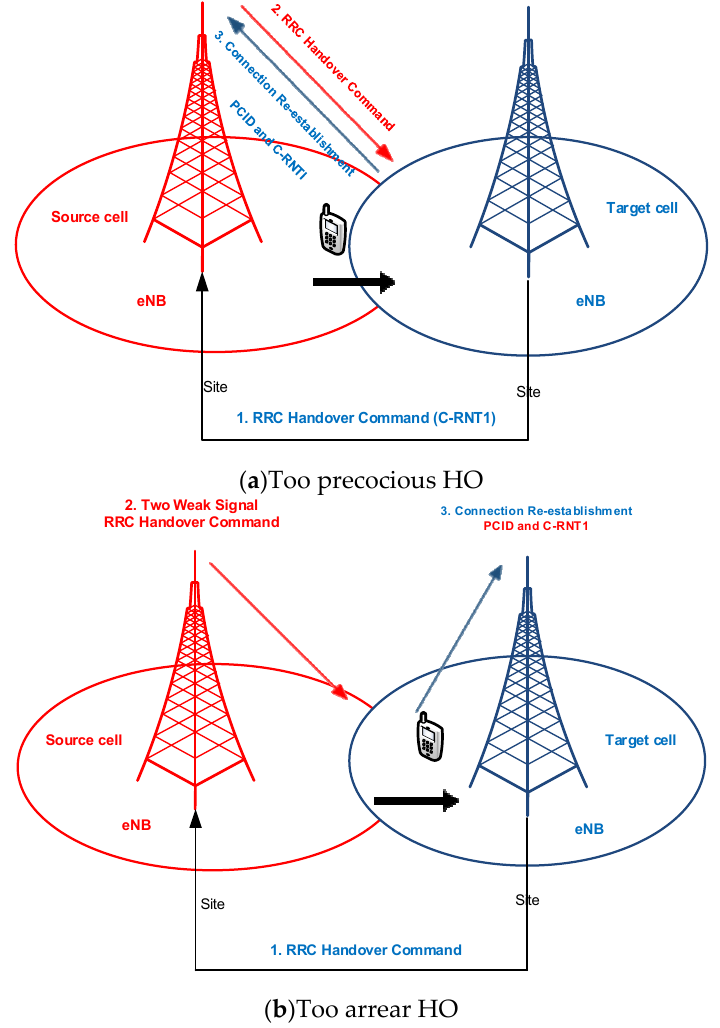
Figure 1. HO problems because of settings of suboptimal HCP [34] .